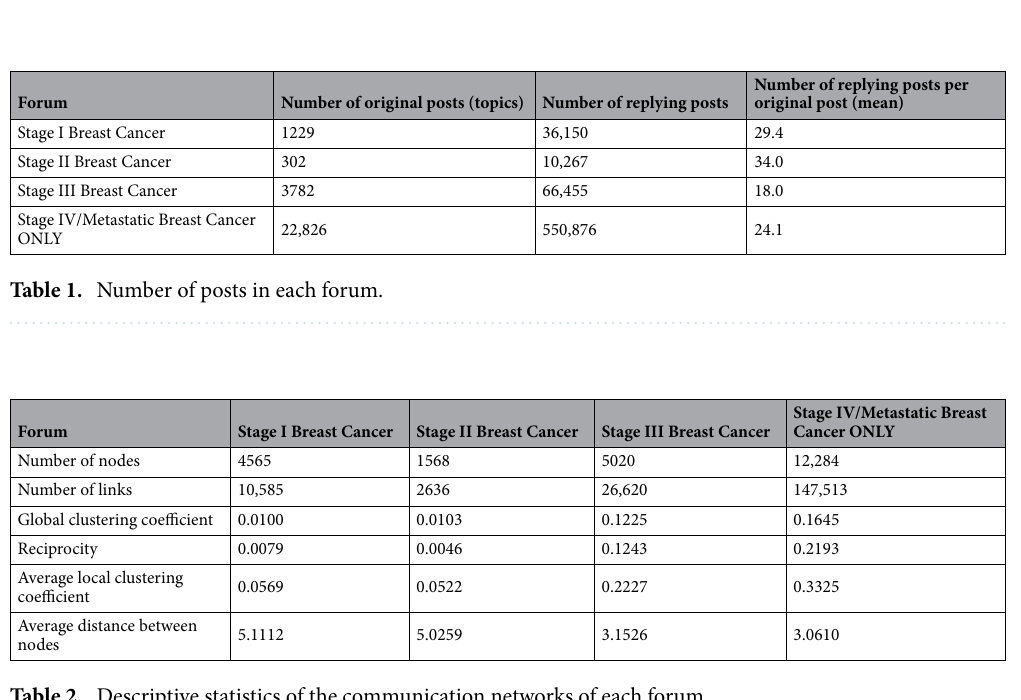
Table 2. Descriptive statistics of the communication networks of each